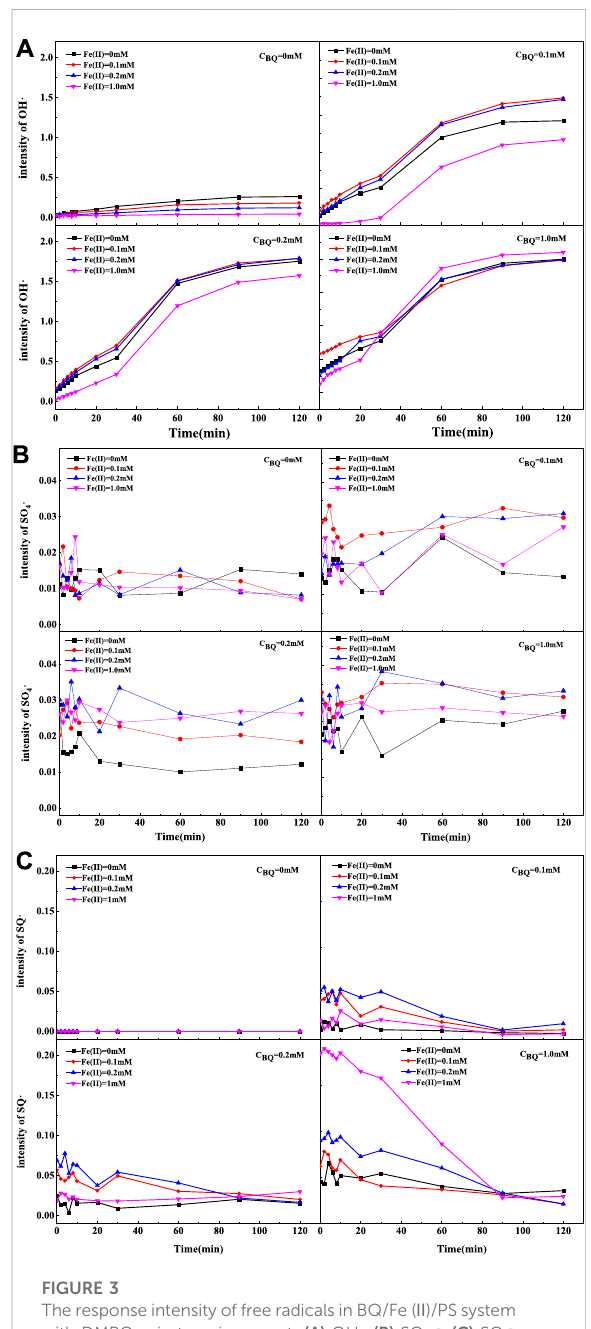
FIGURE 3 The response intensity of free radicals in BQ/Fe ( Ⅱ )/PS system with DMPO spin trapping agent: (A) OH · , (B) SO 4 · - , (C) SQ · -